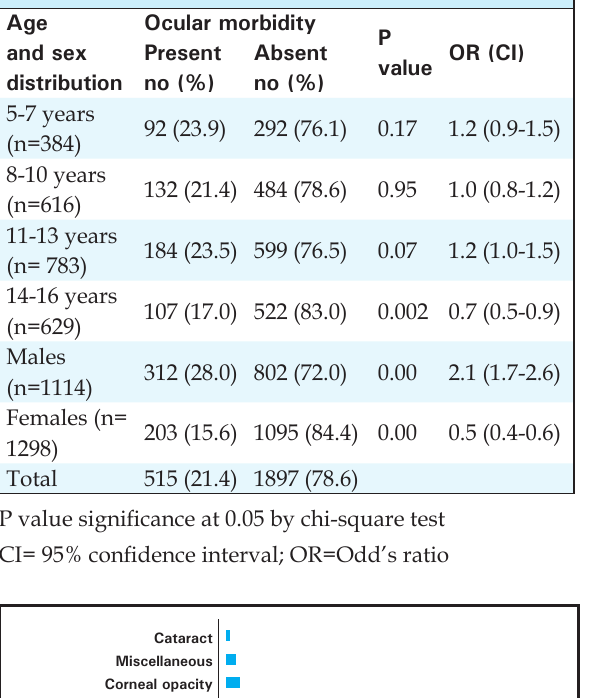
Table 4. Distribution of ocular morbidity in students.